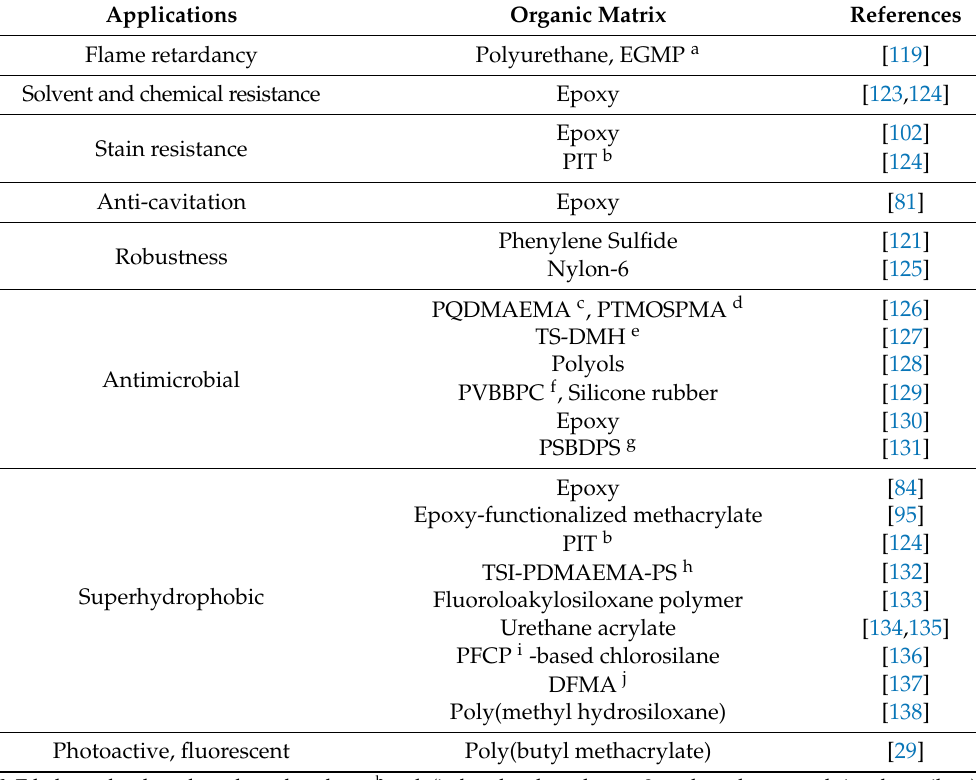
Table 3. Examples of hybrid silica-polymer coating